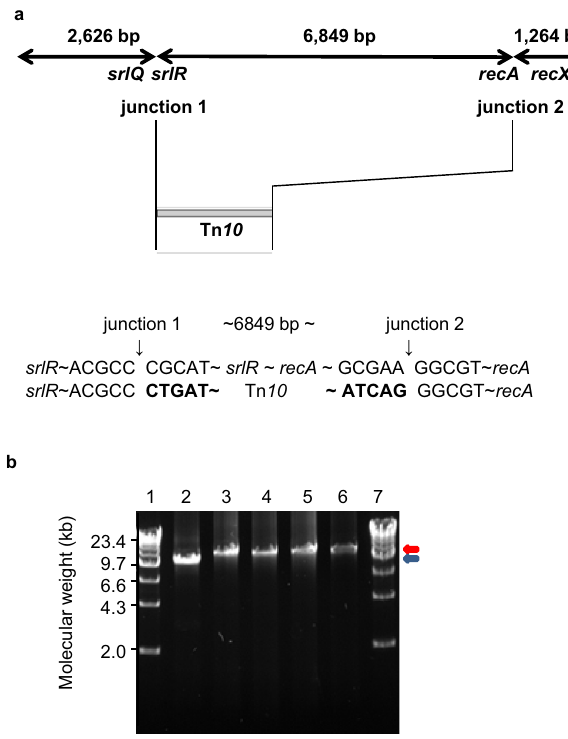
Figure 1. Tolerance of polA25 cells for introducing a ΔrecA306 allele with P1 transduction. ( a ) Genome sequence reference mapping of AQ10459 and AQ10870 against the MG1655 genome and junction points. In ( a ), the top line indicates that the DNA region matches AQ10459 and AQ10870; left 2643 bp and right 1264 bp, or miss in AQ10870; centre 6849 bp with the gene location. Junction sequences of AQ10459 and AQ10870 are shown in the centre and bottom lines, respectively. The results of reference mapping are shown. ( b ) Analysis of recA alleles in ΔrecA polA candidate cells using long PCR. Long PCR was carried out as described in “Methods”. Results of 0.8% agarose gel electrophoresis are shown. Lane 1: marker, lane 2: AQ10459, lane 3: AQ10870, lane 4: ΔrecA306 derivative, lane 5: TK1230 cells, lane 6: TK1224 cells, lane 7: marker. Arrow heads indicate the long PCR product from recA + (blue) or ΔrecA306 (red). The gel image in ( b ) shows a flipped image of the appropriate area without either the extra unnecessary markers or the gel origins from the original photograph (Fig.